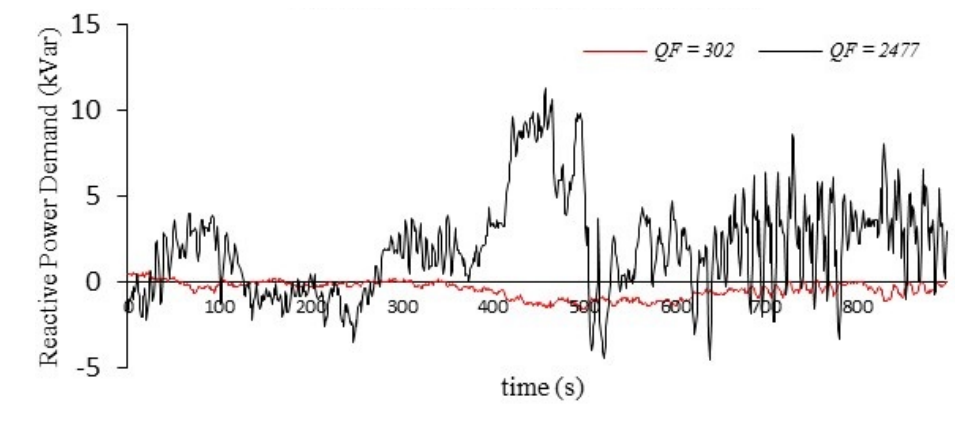
Figure 6. Reactive power demand of node 7 (black curve) and node 3 (red